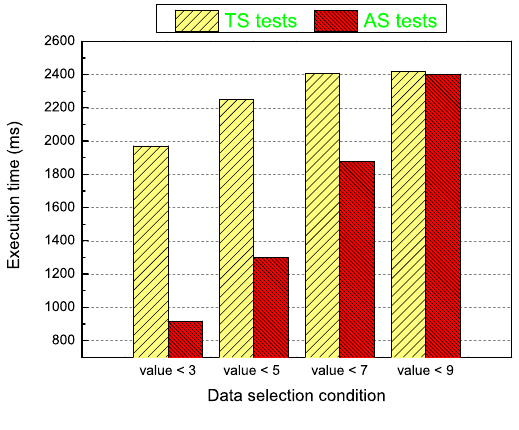
Fig. 4. Application performance under different read size